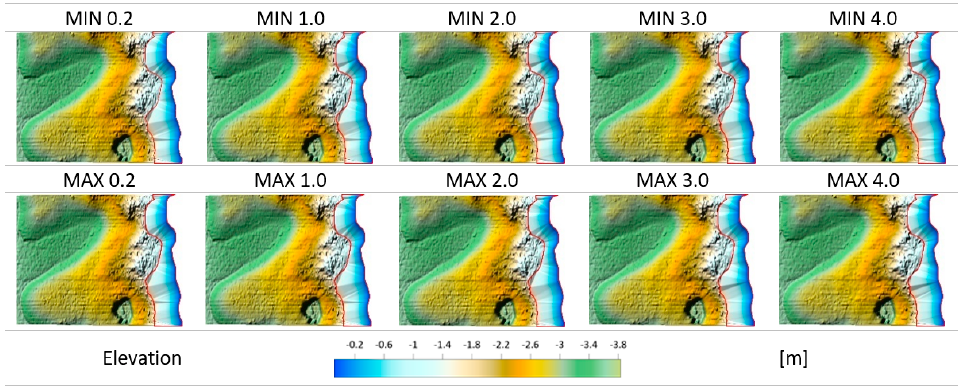
Figure 12. Comparison of DBMs for the triangulation method.